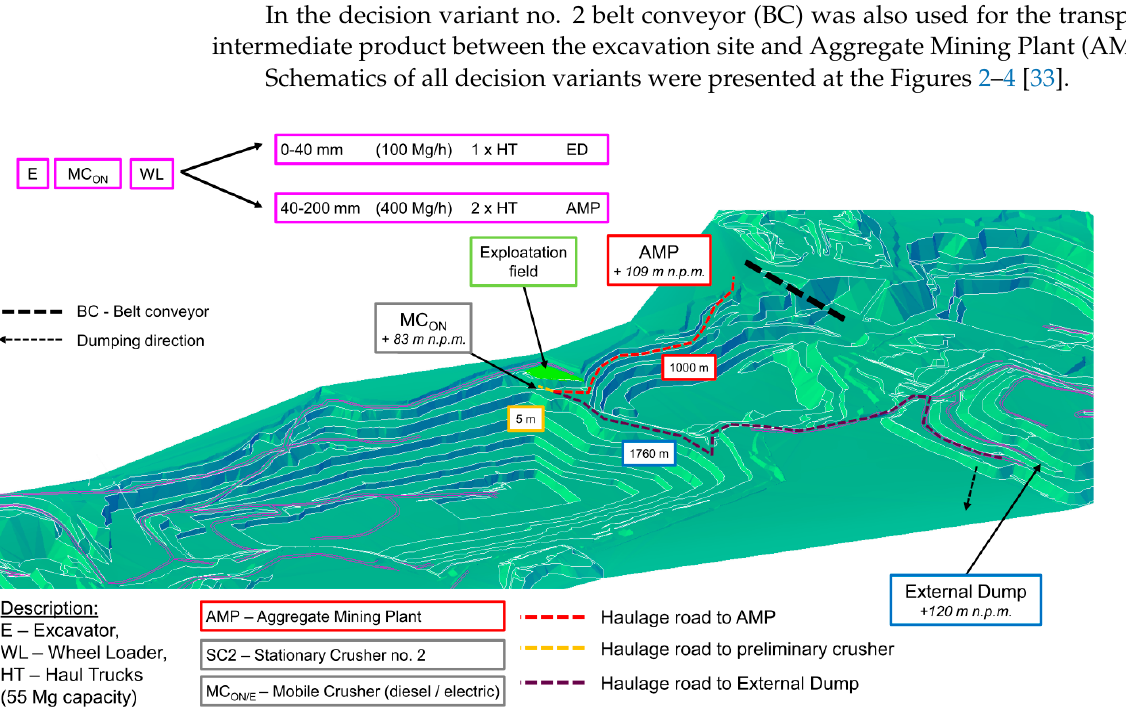
Figure 3. Primary crusher locations in the analyzed mine—Decision Variants no. 2.